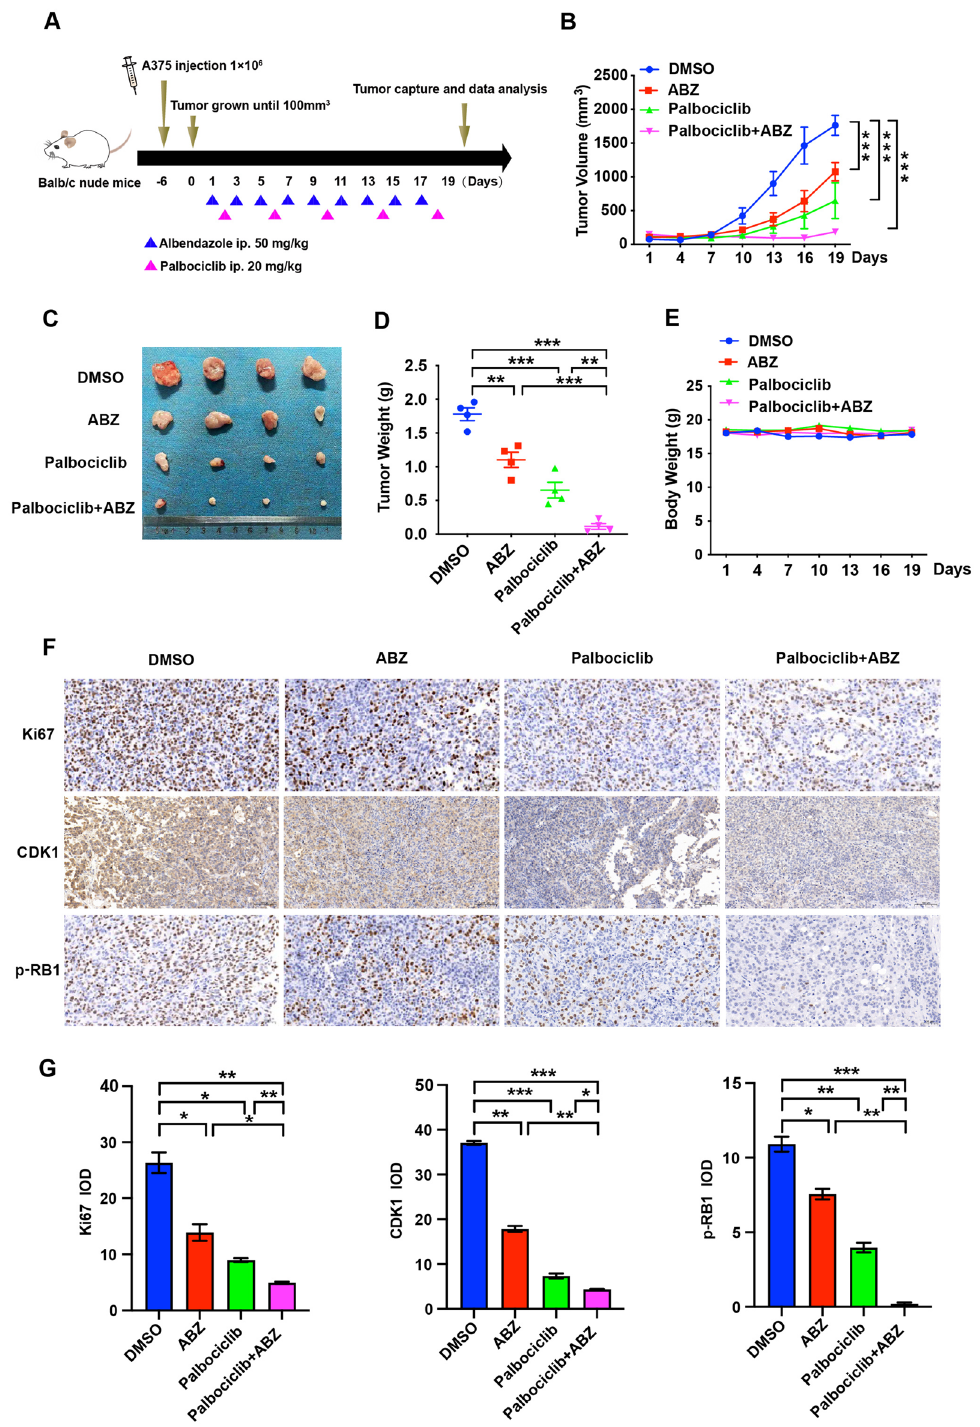
Figure 4. Synergistic effect of ABZ and palbociclib in the treatment of a melanoma xenograft mouse model. ( A ) A375 cells were injected into mice (n = 4 mice per group) on Day -6, and 50 mg/kg ABZ and 20 mg/ kg palbociclib were administered as indicated. ( B ) Tumor volume was measured after ABZ, palbociclib, or ABZ plus palbociclib treatment at the indicated time points. Data represent mean ± SD, *** p < 0.001. ( C ) Representative images of tumors after ABZ, palbociclib, or ABZ plus palbociclib treatment at the end of the experiment in the mouse model. ( D ) Tumor weight was measured on Day 19. Data represent mean ± SD, ** p < 0.01, *** p < 0.001. ( E ) Mouse weight was measured at the indicated time points. F-G. Representative images ( F ) and quantification ( G ) of immunohistochemistry for Ki67, CDK1 and p-RB1 in tumor sections from mouse xenografted melanoma tumors. Data represent mean ± SD, * p < 0.05, ** p < 0.01, *** p <